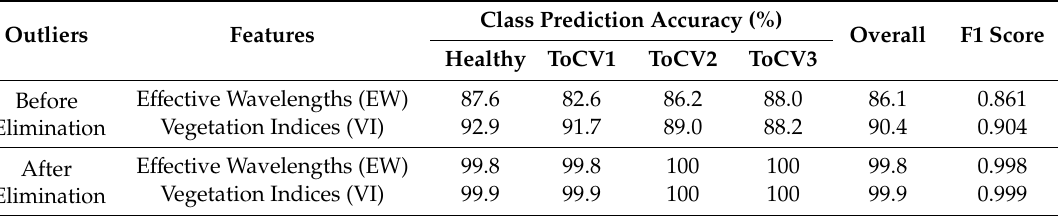
Table 5. XY – Fusion Network (XY-F) classifier prediction performance on the detection of Tomato Chlorosis Virus (ToCV) on the tomato plants and its severity before outlier elimination. Class 1 represents the healthy state and classes 2–4 the severity of the disease in an increasing order, denoted as